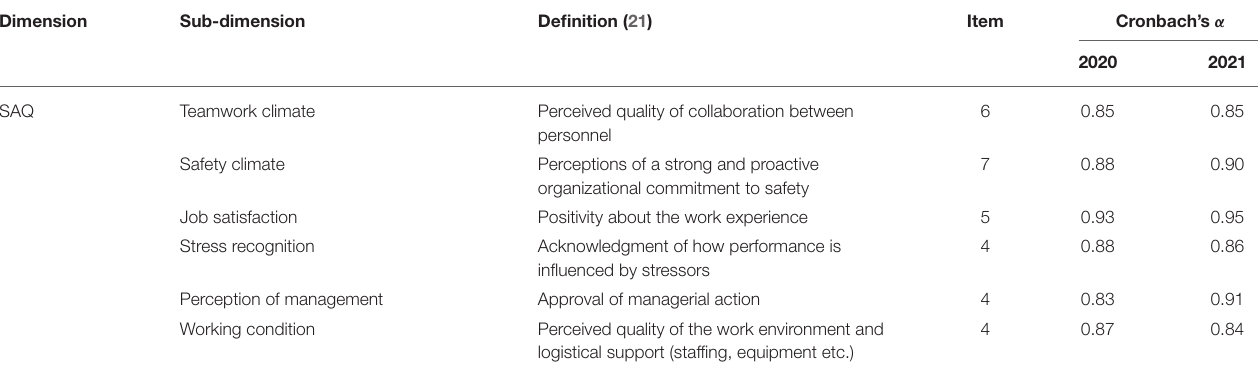
TABLE 1 | Internal consistency reliability of the SAQ.